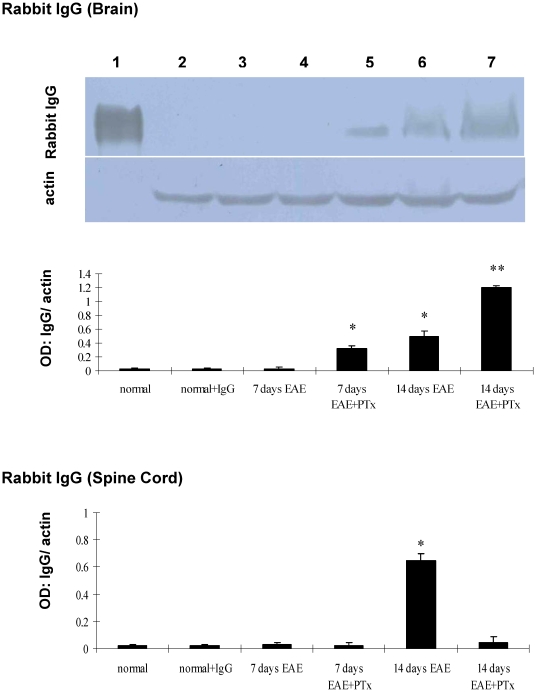
The western blot depicts measures of rabbit IgG.Lane 1: purified rabbit Ig G as the positive control; lane 2–7 correlates the plotted graph below. Statistical evaluation of optic density (OD) normalized to β-actin was obtained for each group. Mean ± SD are depicted (n = 7 per group). *P<0.01, compared with normal control; **P<0.01, compared with normal control group and EAE.